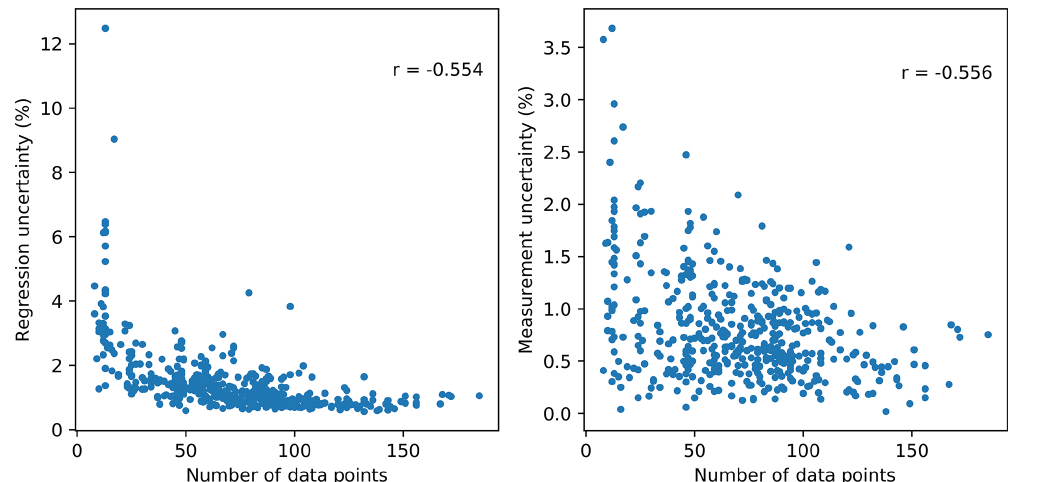
Figure 7. Dependence of linear regression uncertainty and reference wind speed data uncertainty on the number of data points in the period of record for the 472 projects considered in the analysis.